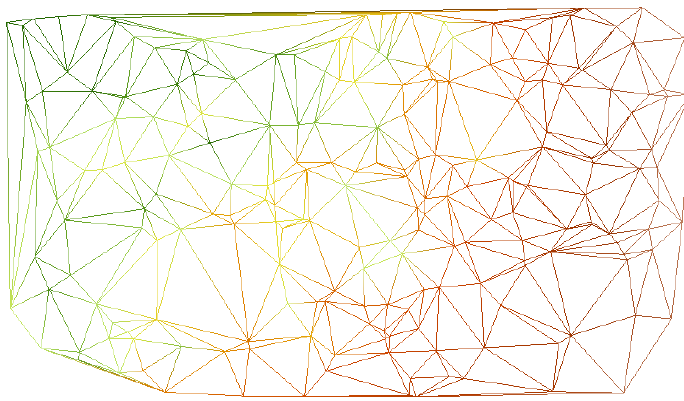
Figure 1. Initial Parallax Triangulation Irregular Network.